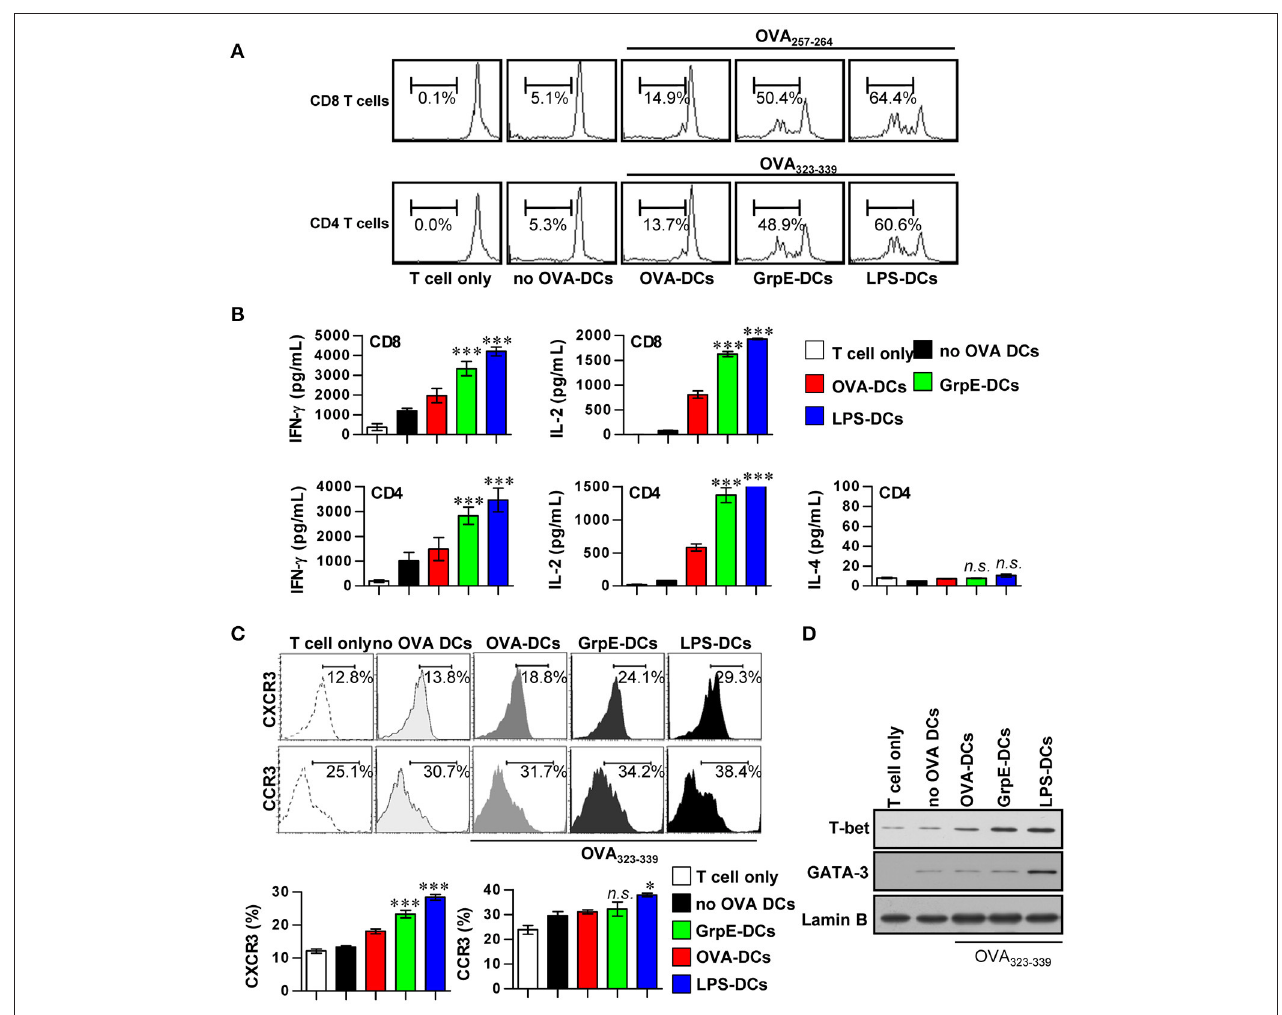
FIGURE 5 | Induction of T cell proliferation and Th1 polarization by GrpE-treated DCs. (A) Transgenic OVA-specific CD8 + T cells and CD4 + T cells were isolated, stained with CFSE, and co-cultured for 96h with DCs treated with GrpE (10 µ g/mL) and LPS (100ng/mL), then pulsed with 1 µ g/mL OVA 257 – 264 or OVA 323 – 339 for OVA-specific T cells, respectively. T cells only and T cells co-cultured with untreated DCs (no OVA-DCs) served as controls. The proliferation of CD4 + and CD8 + T cells was then assessed by flow cytometry. This data is shown representative of three independent experiments . (B) At 96h after co-culture, IFN- γ , IL-2, and IL-4 levels in culture supernatants were analyzed by ELISA. (C) T cells were stained with anti-CXCR3 mAb or anti-CCR3 mAb. The percentage of positive cells is shown for each panel. Histograms and bar graphs show CXCR3 + or CCR3 + T cells in the OVA-specific CD4 + T cells. The mean ± SD ( n = 3 samples) is shown representative of three independent experiments and statistical significance (* p < 0.05 or *** p < 0.001) is shown for treatments when compared to the appropriate controls (T cell/OVA-pulsed DCs, red bars). Treatments with no significant effect are indicated as n.s . (D) T-bet and GATA-3 expression in the OVA-specific CD4 + T cells